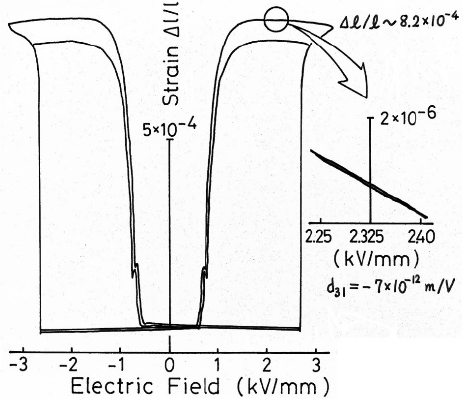
Figure 18. Piezoelectric d 31 measurement in the induced ferroelectric phase in Pb 0.99 Nb 0.02 [(Zr 0.6 Sn 0.4 ) 0.94 Ti 0.06 ] 0.98 O 3 .